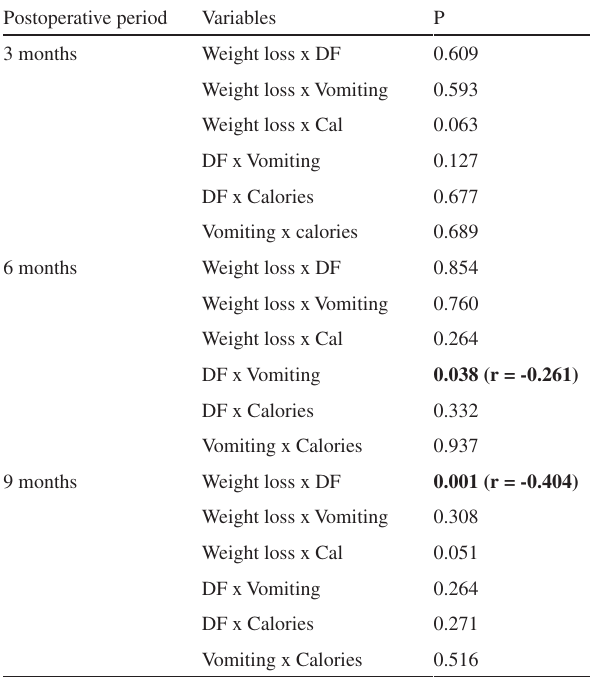
Table 4 - Correlation between weight loss, diet fractionation and vomiting episodes Postoperative